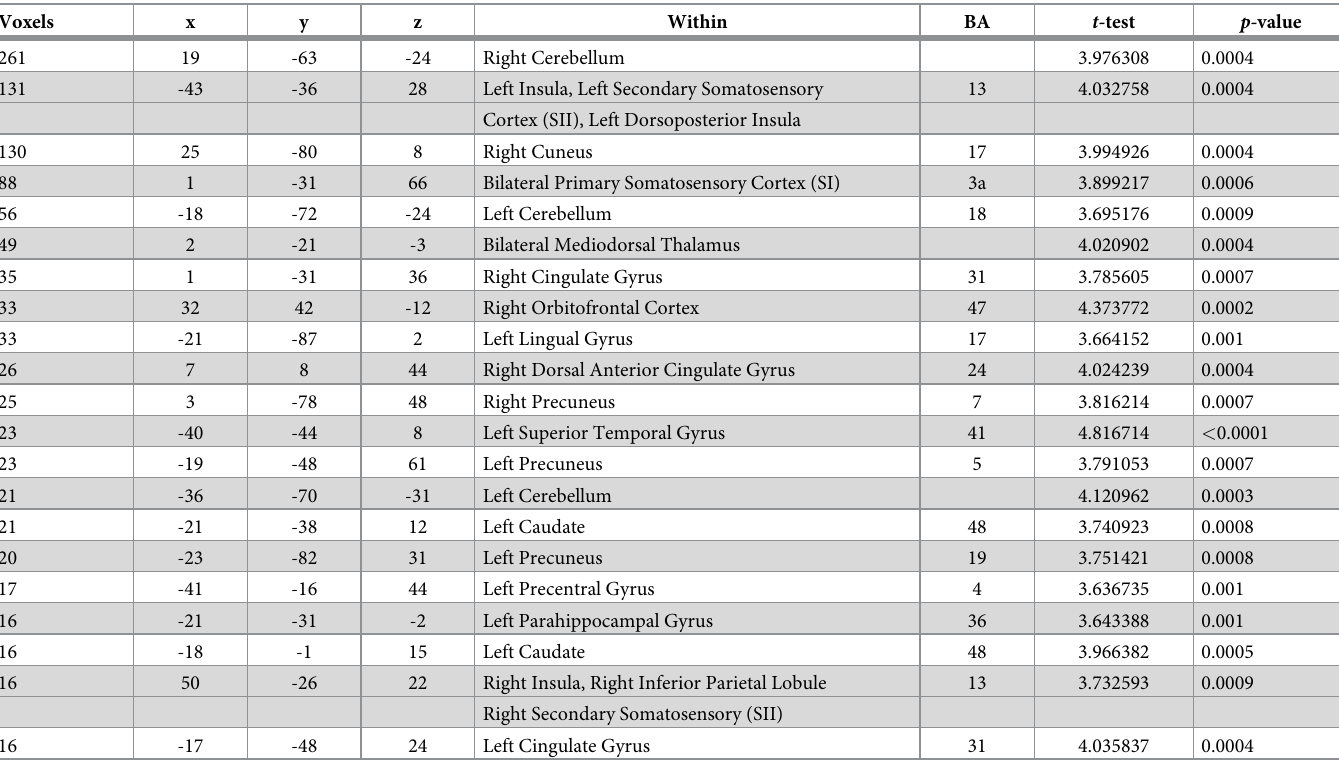
Table 3. Cluster results for group × time analysis of noxious thermal